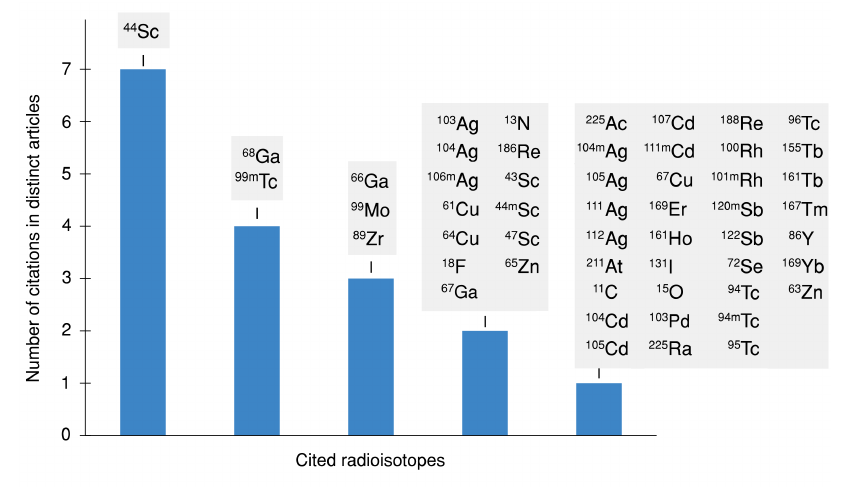
Figure 2. Number of papers that cited the production of each